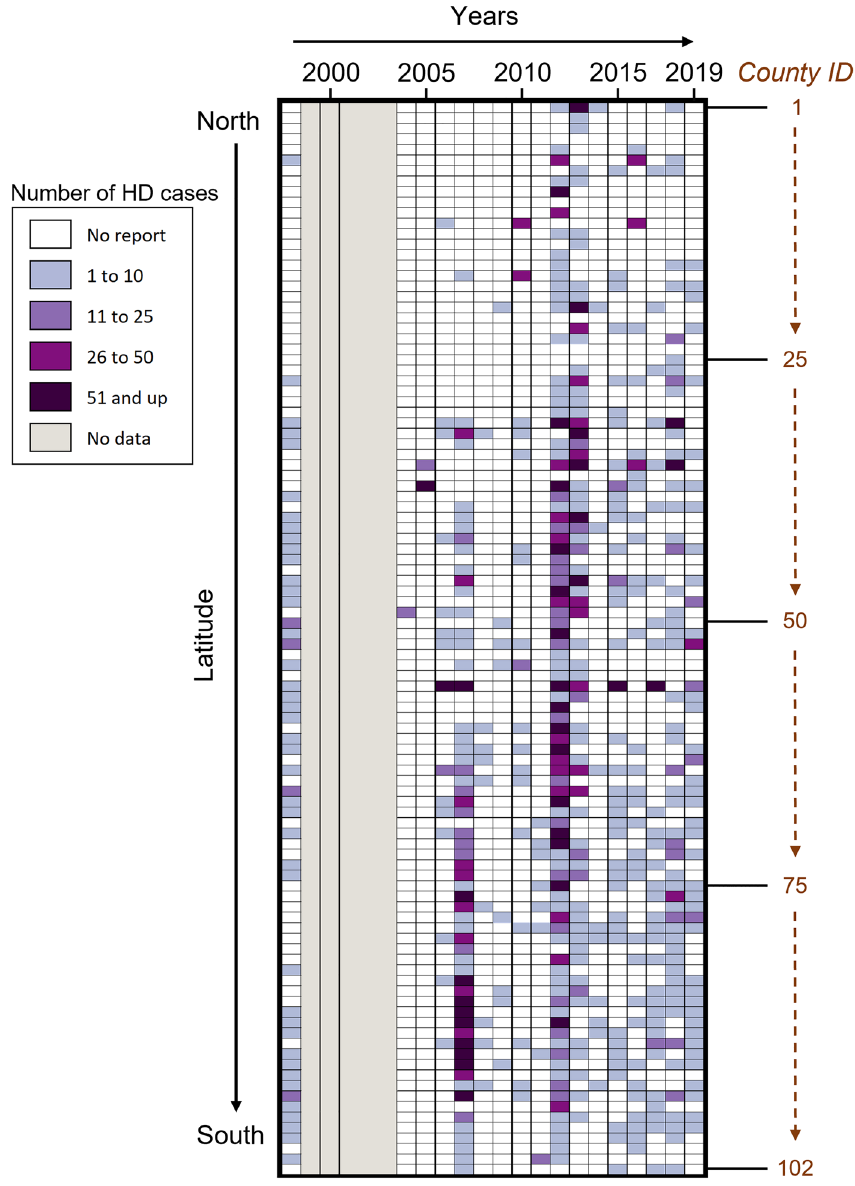
Figure 2. Number of hemorrhagic disease (HD) cases per county in wild white-tailed deer in Illinois by decreasing latitude from 1998 to 2019. Individual cells in a column represent each county in the state of Illinois and are assigned a county ID 1–102; The ID number and county name are given in Supplementary Figure